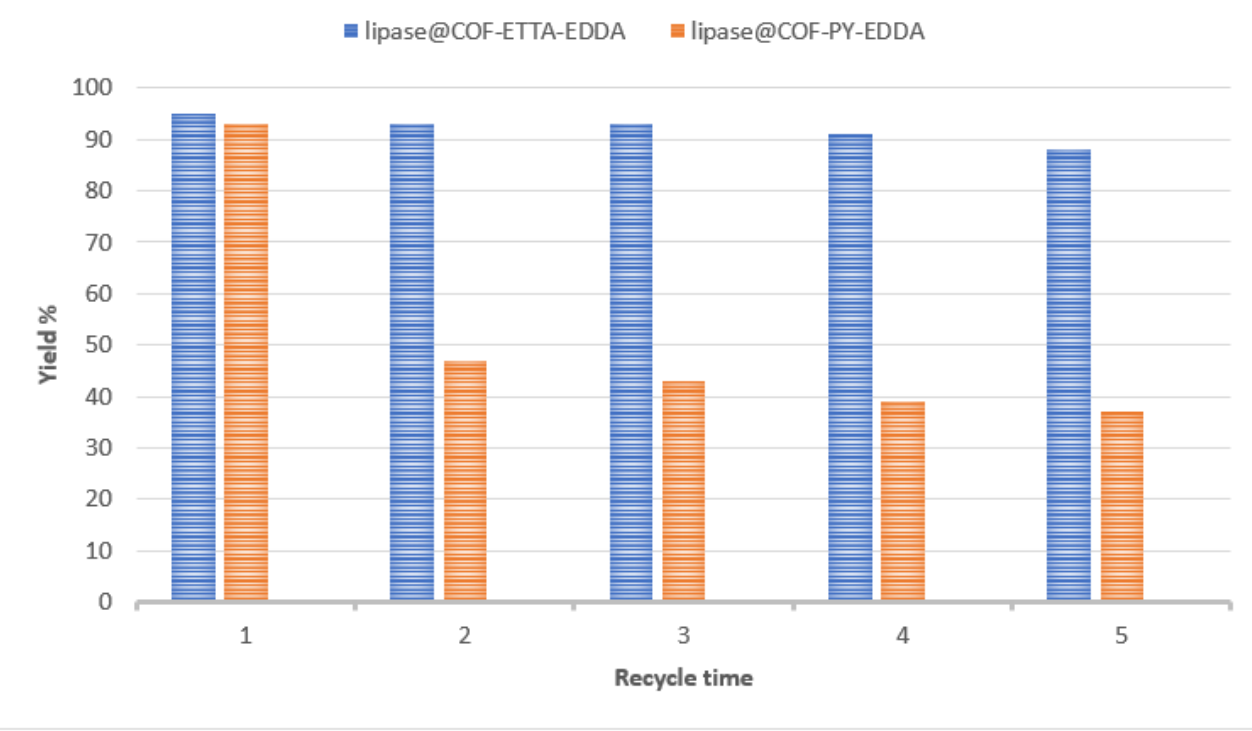
Figure 11. Recycling capability of COF – PY – EDDA and COF – ETTA – EDDA.